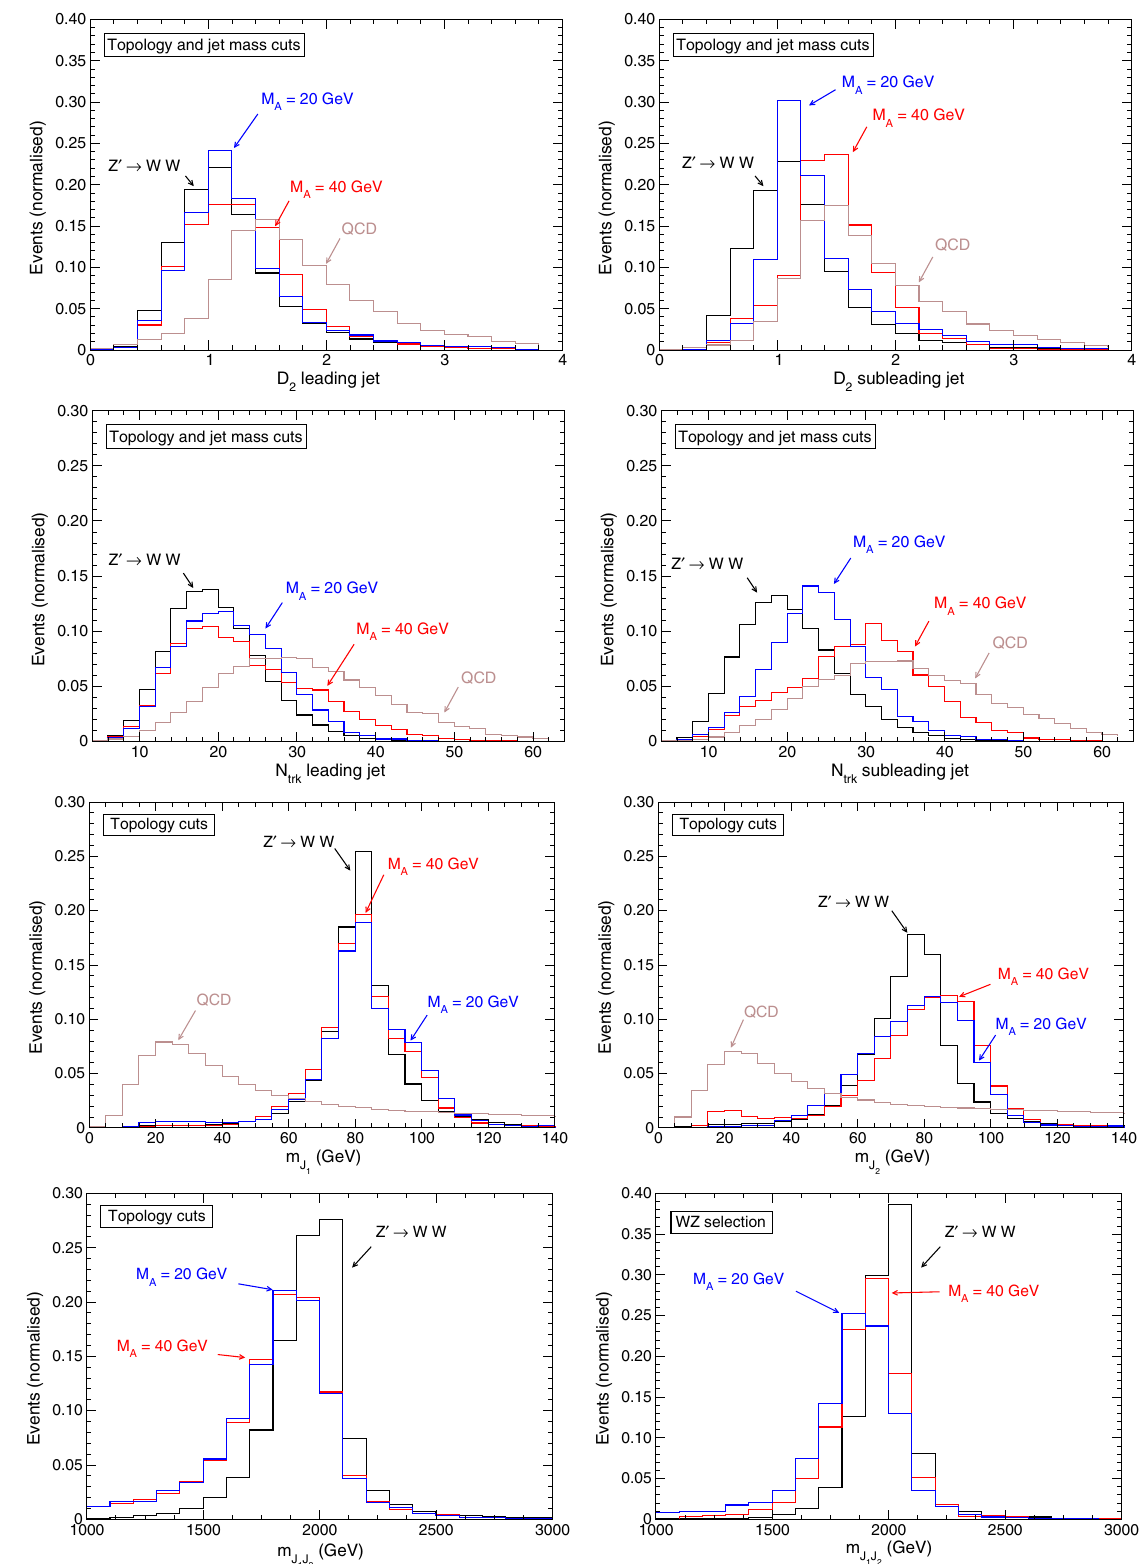
Fig. 10 Distributions for the R → V S and Z (cid:8) → WW signals and the QCD dijet background in the ATLAS analysis. Top: D 2 variable; second row: number of tracks; third row: jet mass; bottom: dijet invariant